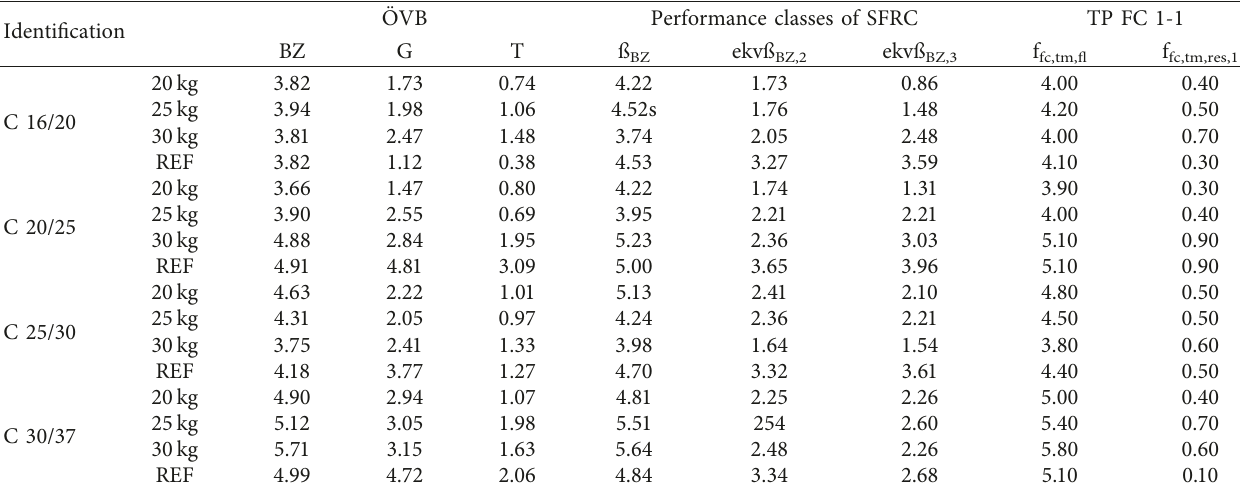
Table 7: Summary table with the results of assessment of the performed bending tests in MPa. Identification